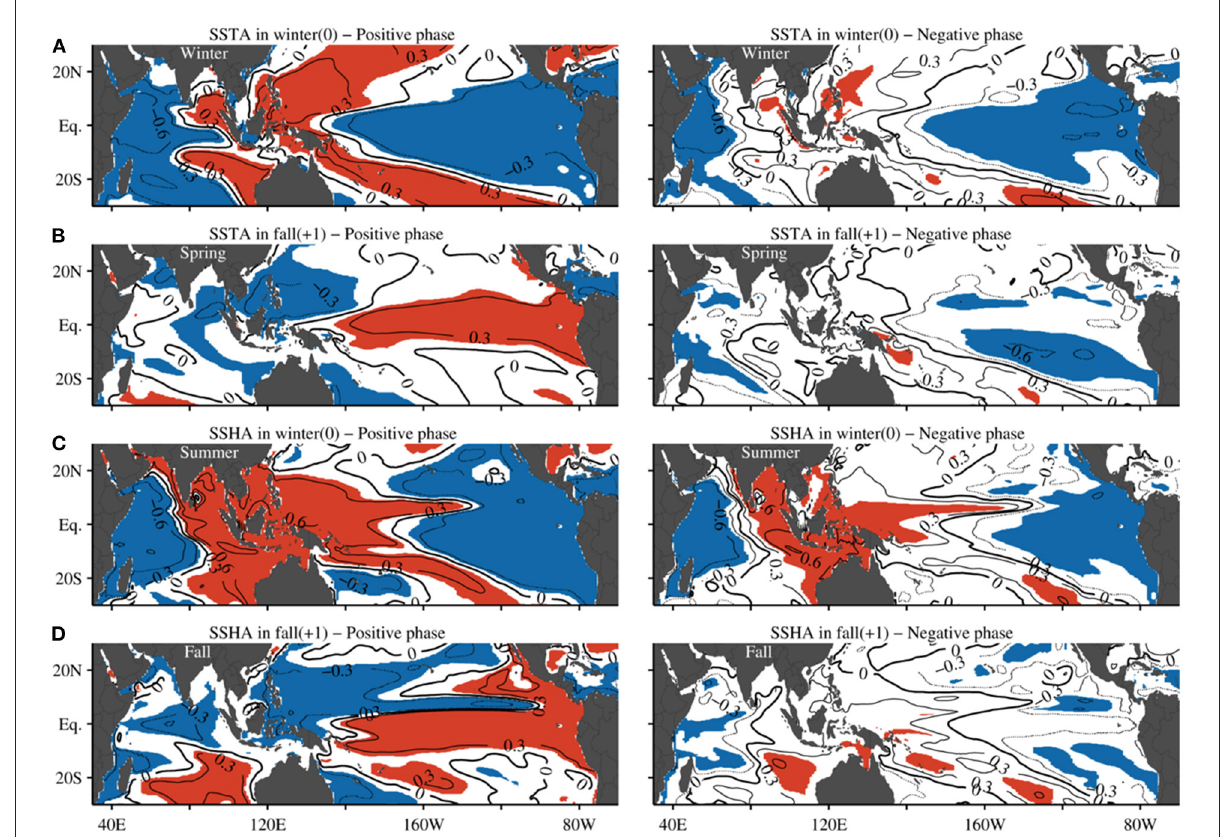
FIGURE15 Comparison of lag correlations between the SSTA or SSHA in STIO in fall and the tropical Indo-Pacific SSTA or SSHA during the positive (left column) and negative (right column) phases of the decadal variability in the CCSM4 historicalNat simulations. (A) Lag correlations of SSTA in the winter of Year 0. (B) Lag correlations of SSTA in the fall of Year + 1. (C) Lag correlations of SSHA in the winter of Year 0. (D) Lag correlations of SSHA in the fall of Year + 1. The contour interval is 0.3. Red and blue shades indicate 99% confidence level of positive and negative correlation,